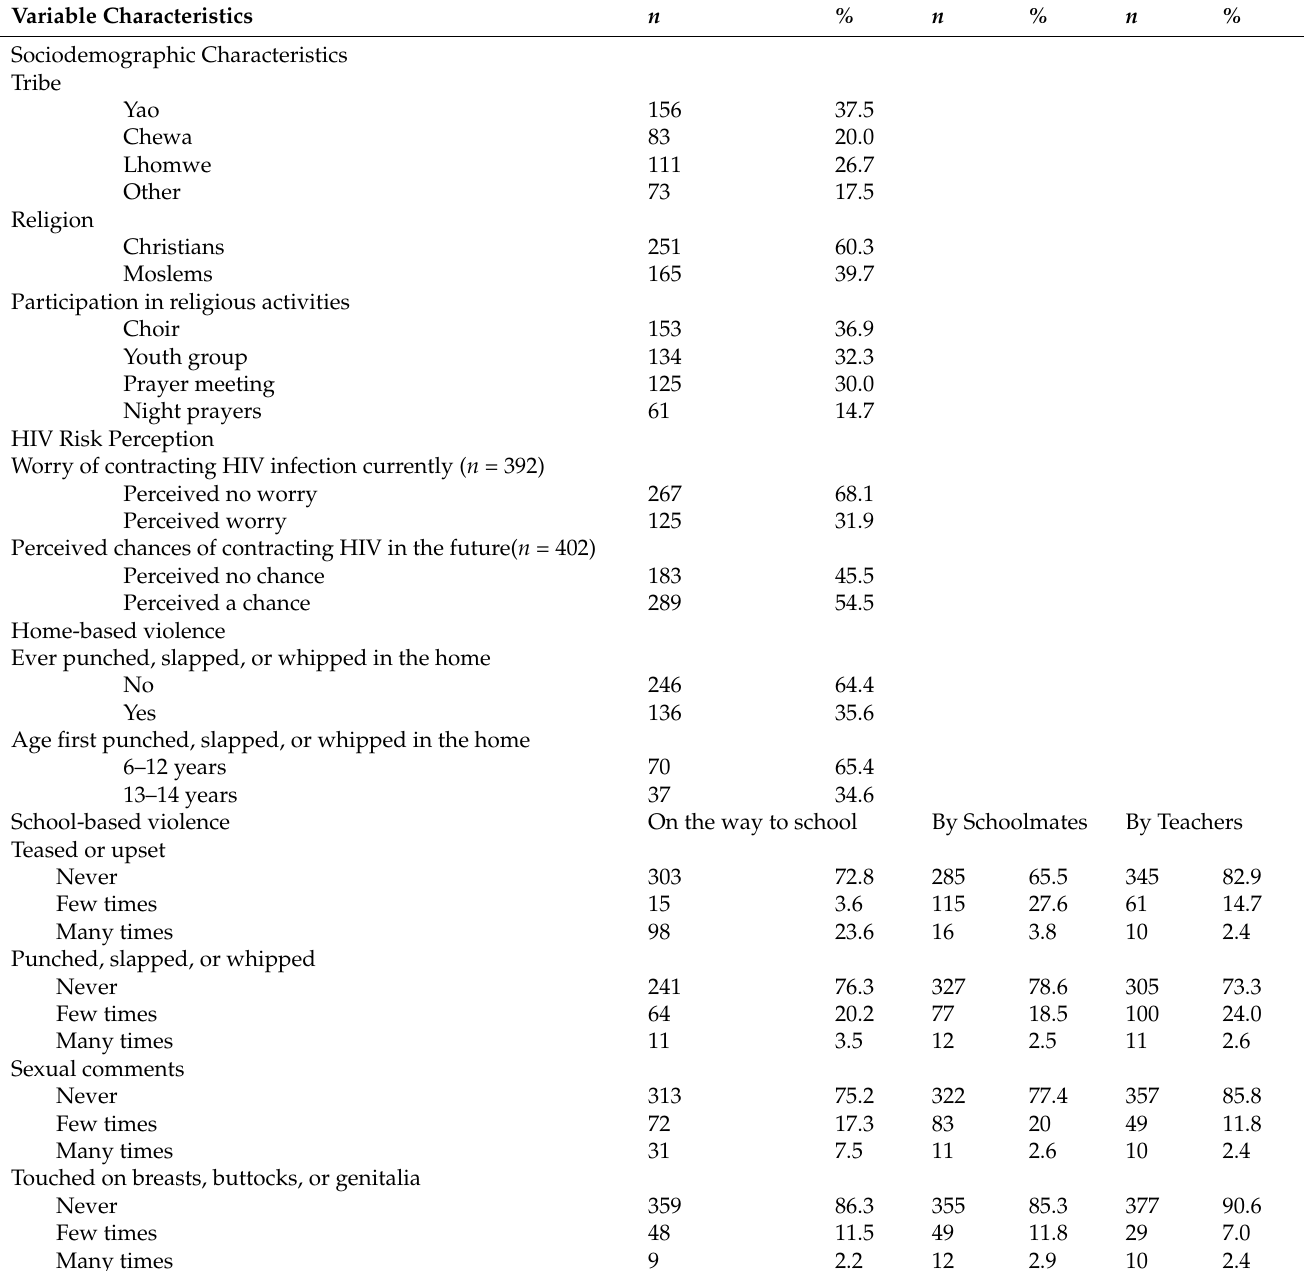
Table 1. Sociodemographic and violence characteristics of the young adolescents ( N =